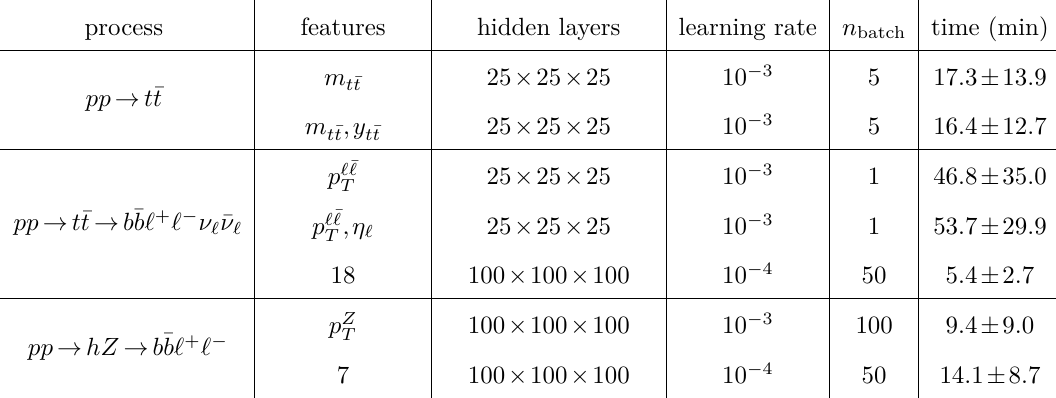
+ 3 n eft ) / 2 independent eft